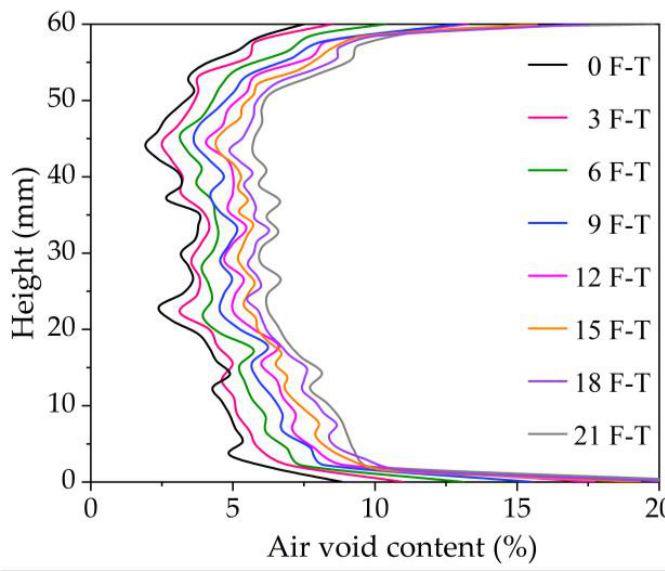
Figure 6. Distribution of internal air void content of asphalt mixture under F – T cycles.